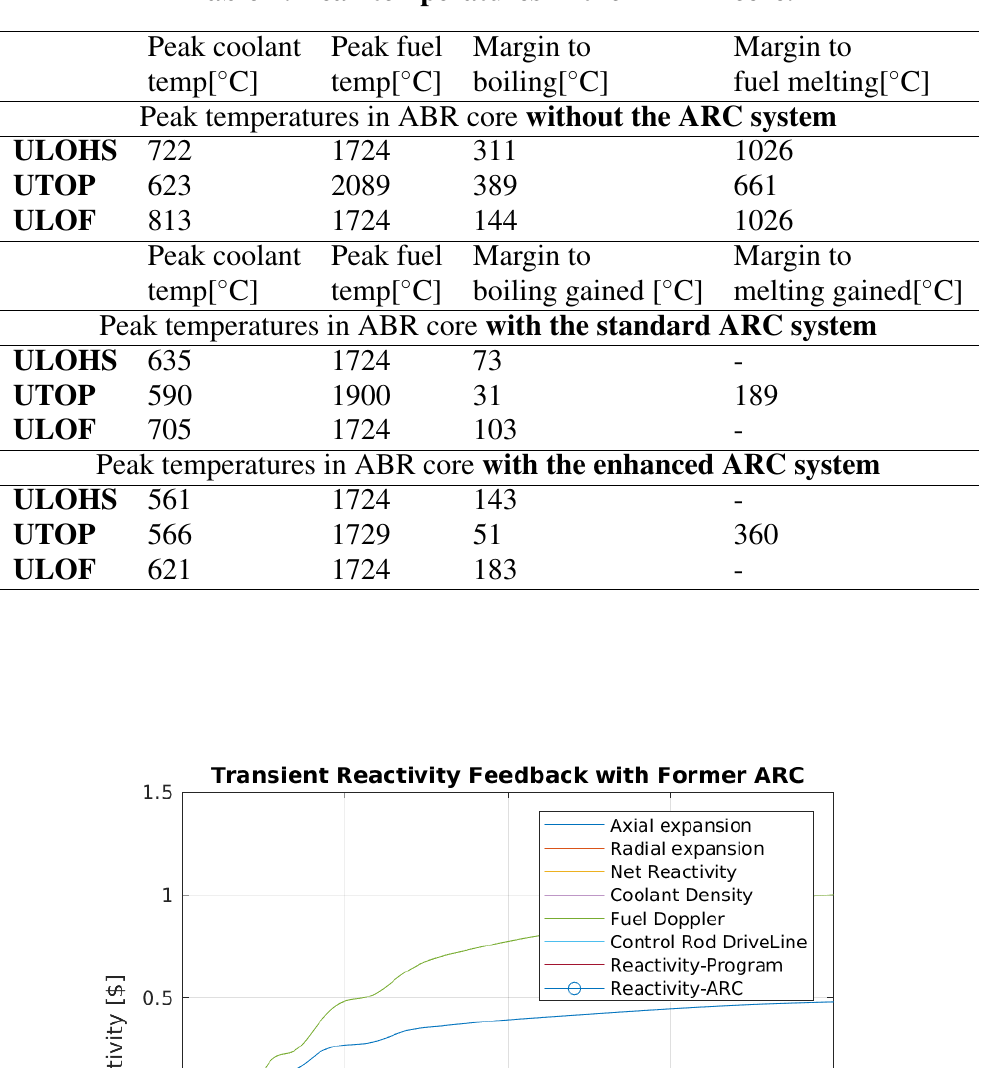
Table 2: Peak temperatures in the in ABR core.